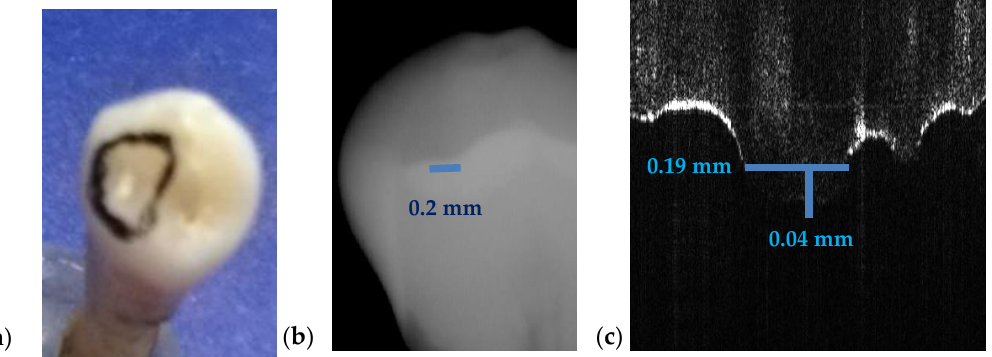
Figure 17. ( a ) Canine tooth, with an area marked for OCT investigations; ( b ) a section cropped from the intraoral radiography where the cavity was measured; ( c ) OCT B-scans with measurements of depth and width of the cavity.